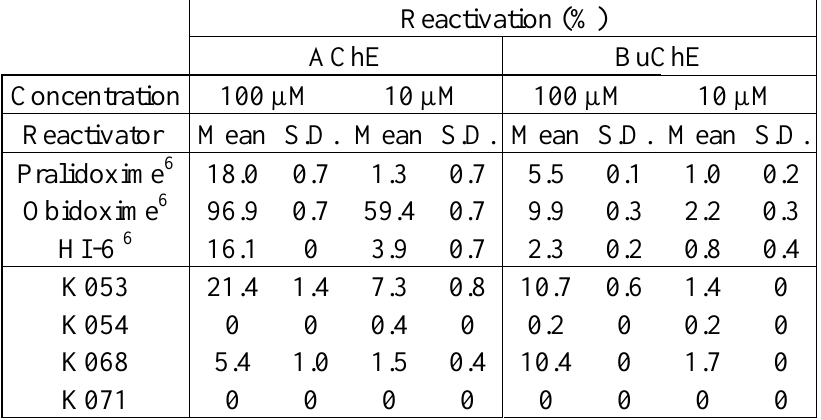
Table 1. Potency of the tested oximes to reactivate POX- inhibited human erythrocyte AChE and plasma BuChE at concentrations 100 µM and 10 µM. (%, mean value of three independent determinations, time of inhibition by paraoxon 120 min; time of reactivation by AChE reactivators - 10 min; pH 7.4; temperature 25